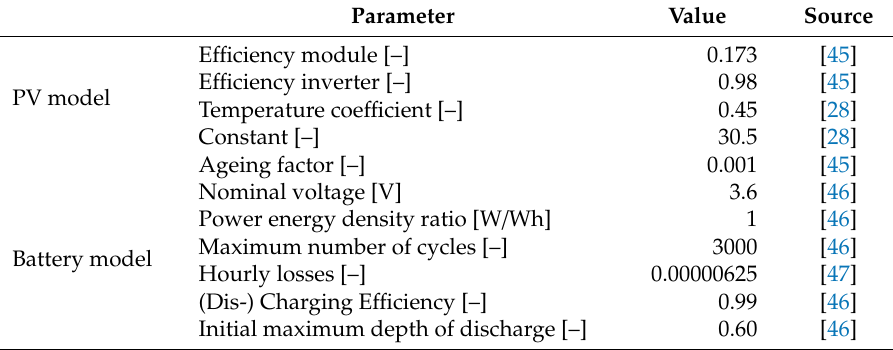
Table 1. Specification of the input parameters of the PV and battery